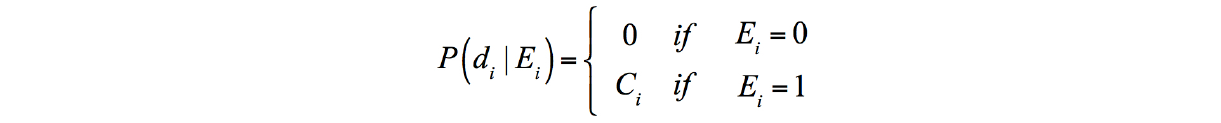
Figure 4. Probability of factor specific fall event given exposure.